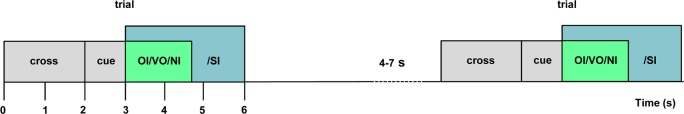
The experimental paradigm.At t = 0 s, a fixation cross is presented followed by a cue at t = 2 s. The cue stays until t = 3 s. Participants performs OI, NI, and VO from t = 3 s to t = 4.7 s. SI lasts from t = 3 s to t = 6 s.